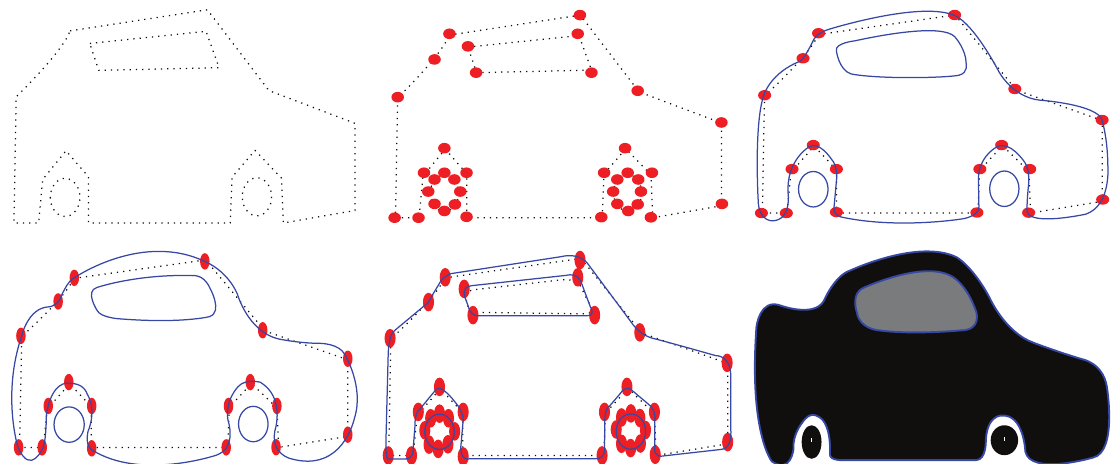
Figure 9: Rational spline interpolants for the design of a